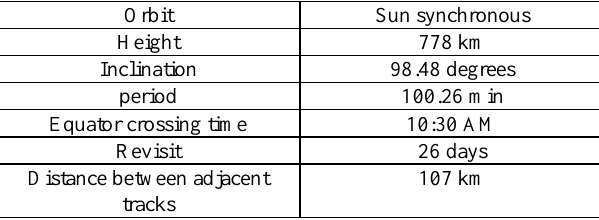
Table 1. Orbital specifications of the satellite